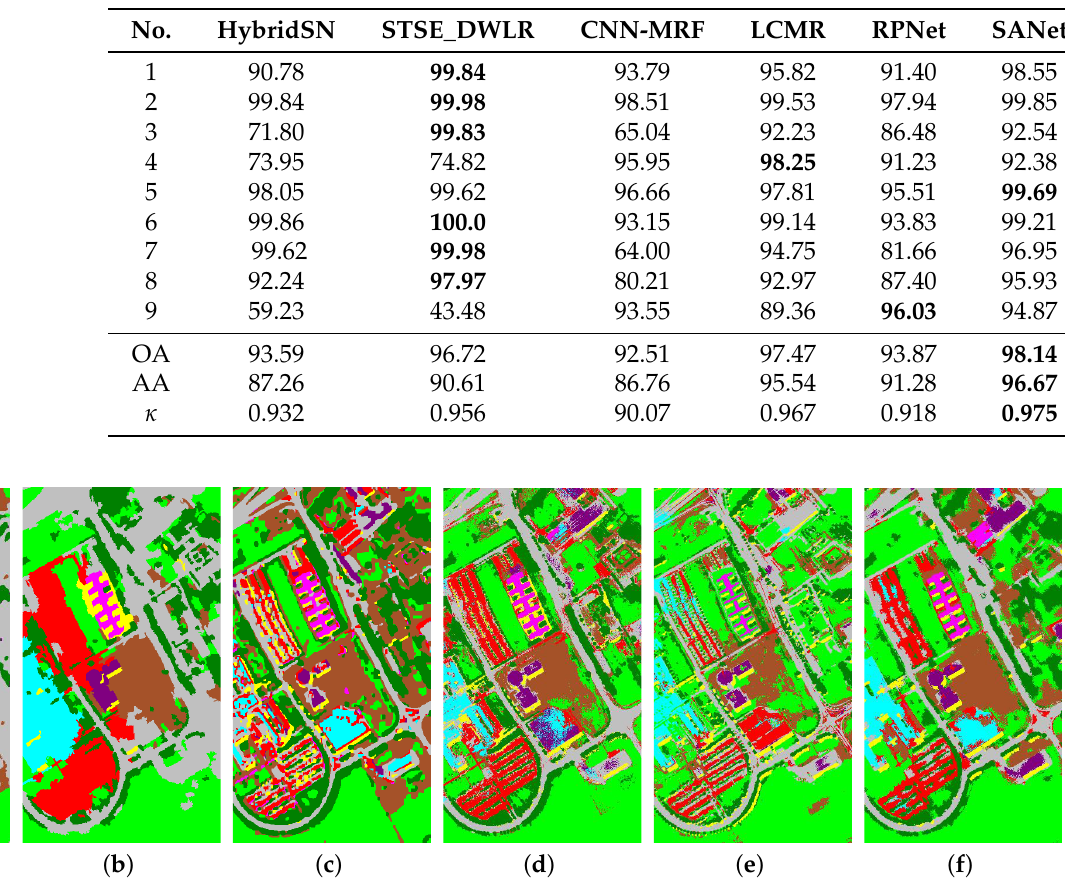
Figure 12. Classification maps for the University of Pavia data set using different methods. ( a ) HybridSN; ( b )